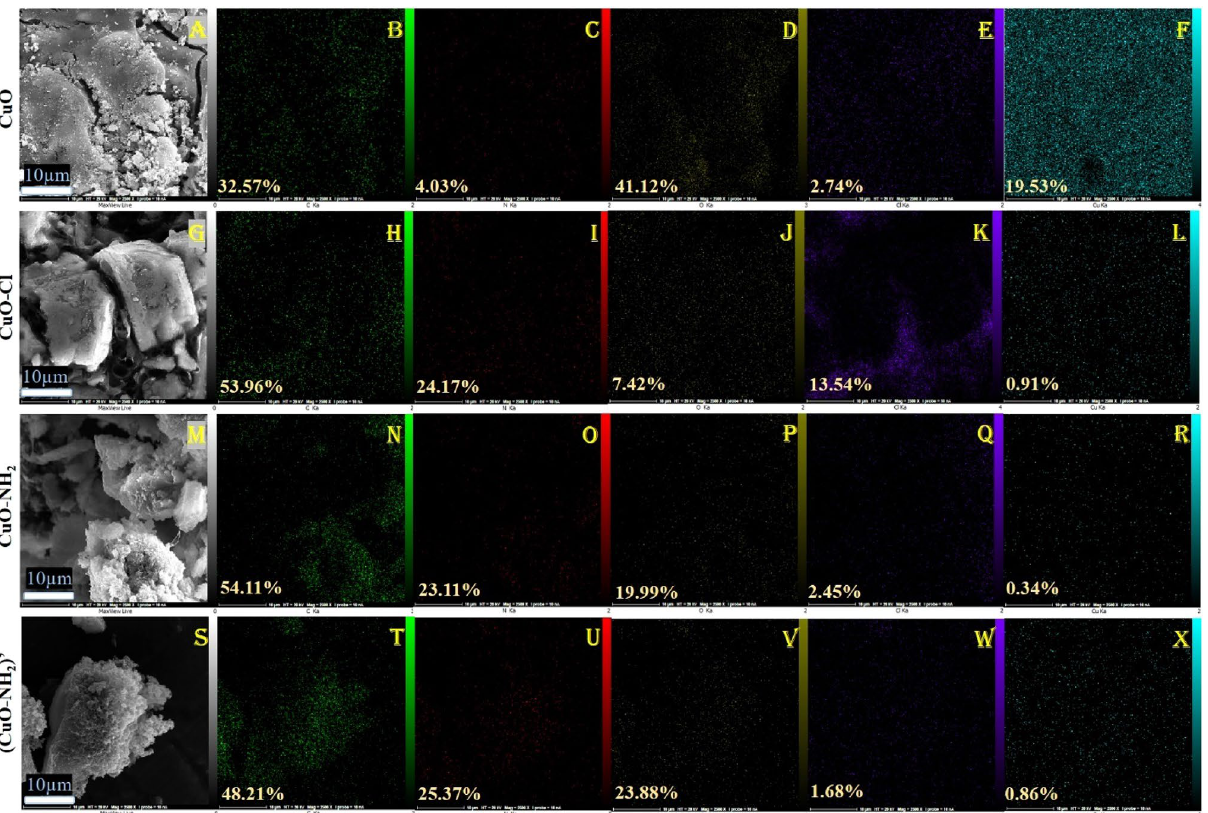
Figure 4. The EDS and mapping analysis of prepared nanoparticles, ( A – F ) CuO, ( G – L ) CuO–Cl, ( M – R ) CuO–NH 2 , and ( S – X ) CuO–NH 2 after photocatalysis activity (CuO–NH 2 )’. Green: carbon, Red: nitrogen, Gold: oxygen, Violet: chlorine, and Blue: